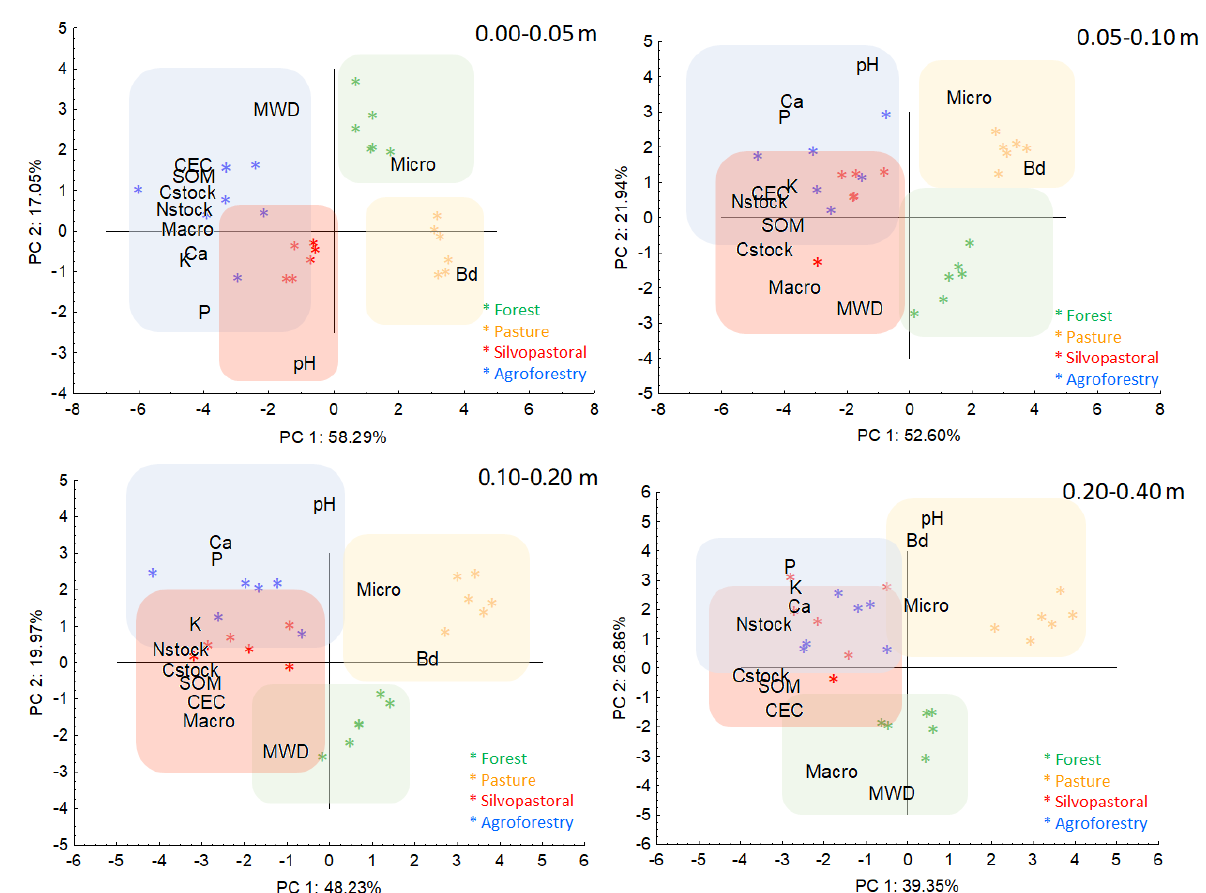
Figure 3. Principal component analysis of physical and chemical attributes of a Quartzipisamment under different use and management systems (foresty, pasture, agroforestry, and